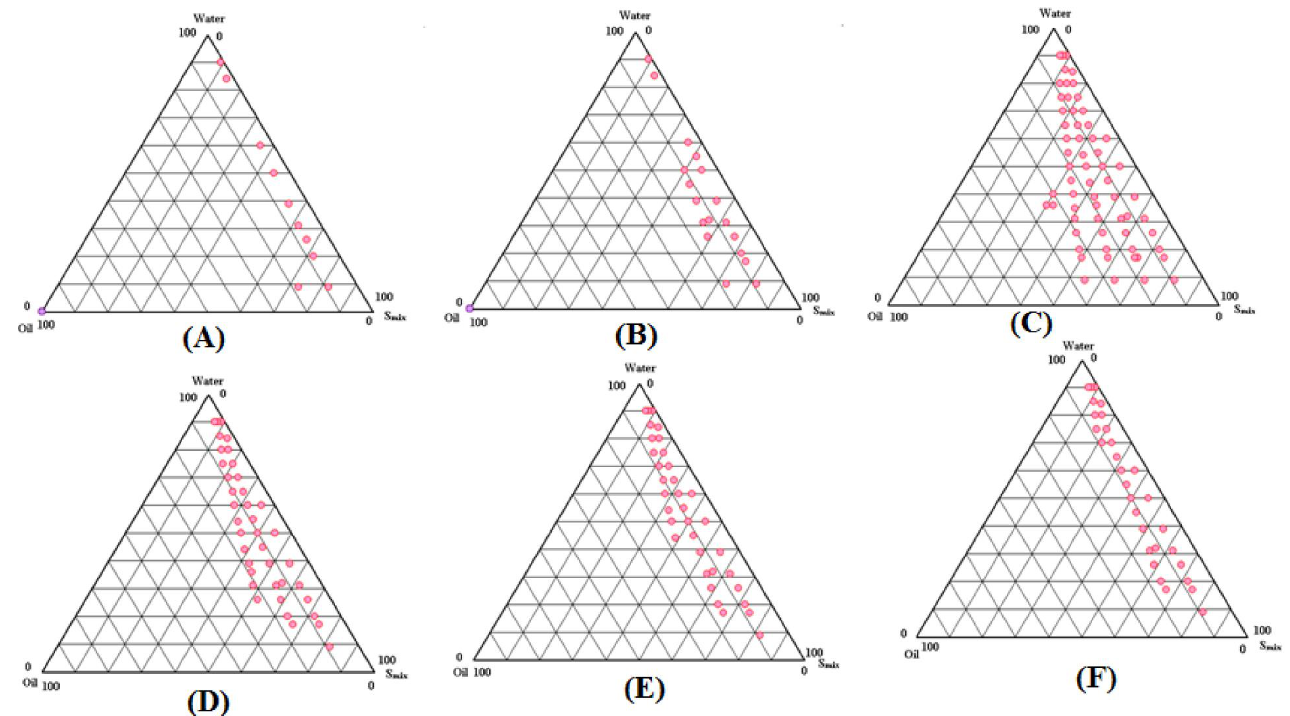
Figure 1. Pseudo-ternary phase diagrams showing SNEDDS zones for oil phase (Lauroglycol-90), aqueous phase (water), surfactant (Tween-80) and cosurfactant (Transcutol-HP) at S mix ratios of ( A ) 1:0, ( B ) 1:2, ( C ) 1:1, ( D ) 2:1, ( E ) 3:1, and ( F ) 4:1.